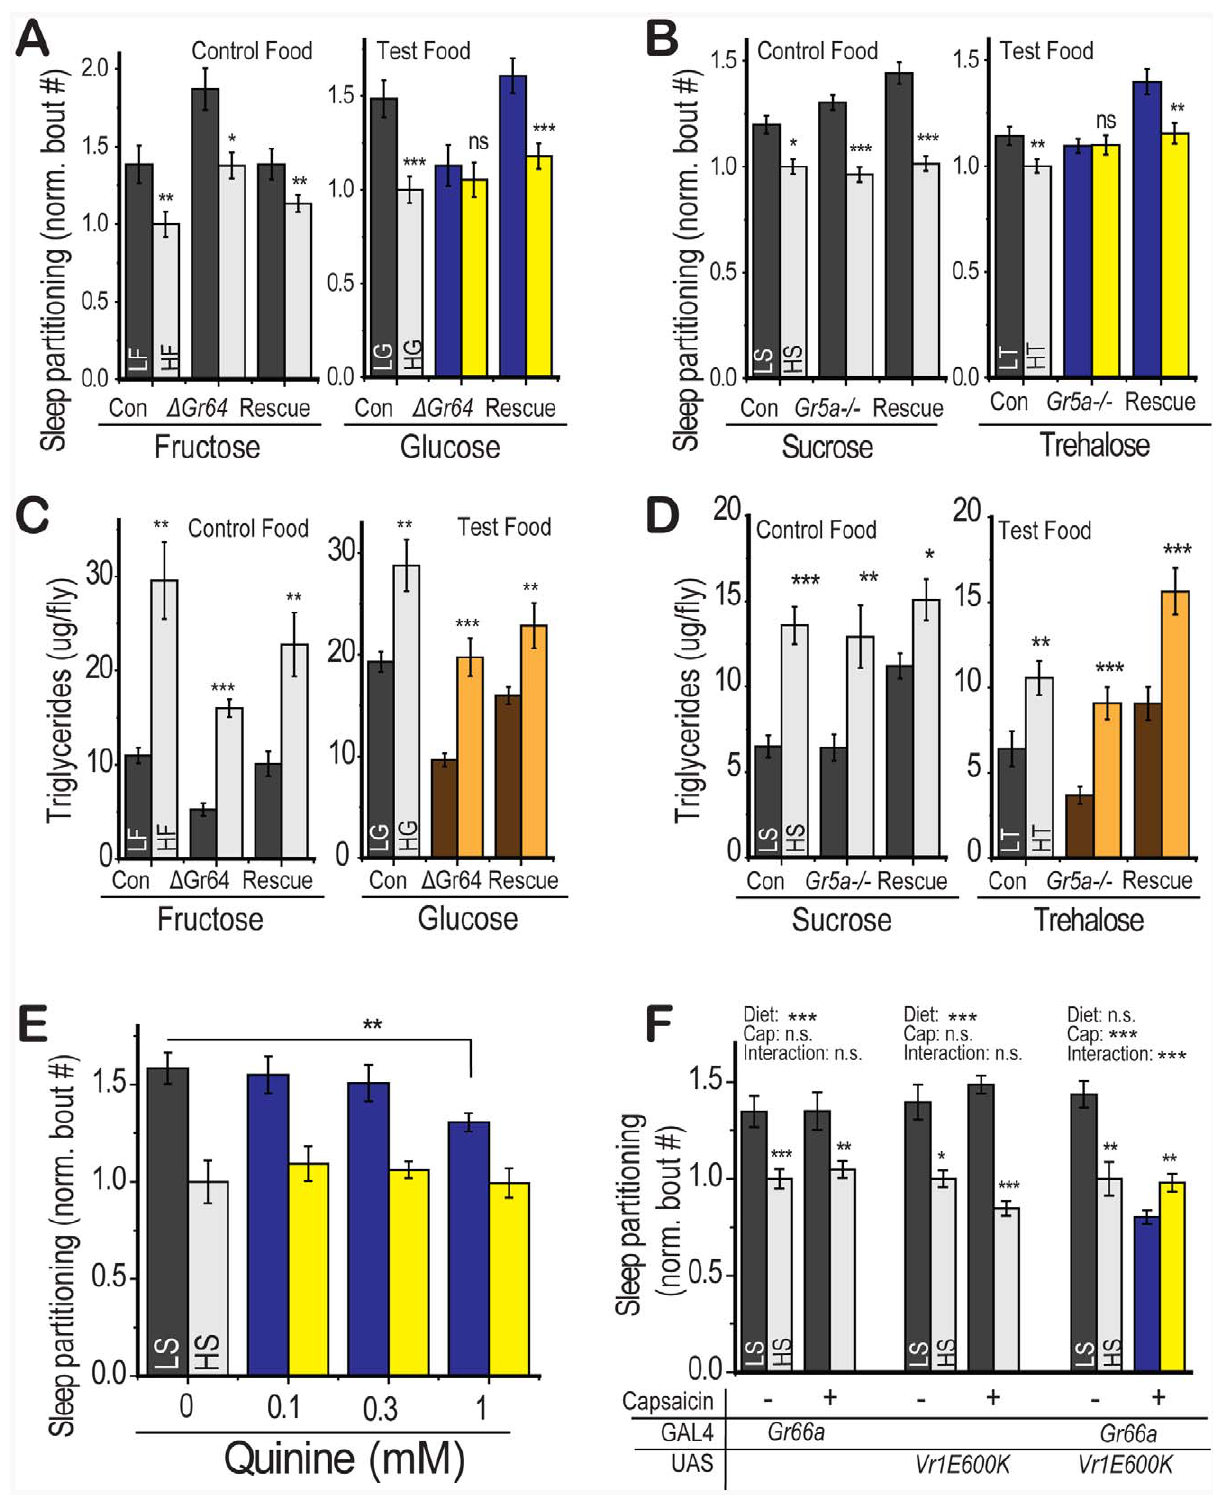
Figure 5. Gustatory inputs mediate sleep partitioning in response to dietary sugar. For each indicated sugar, flies were tested on a medium with 2.5% or 30% of that sugar on a 2.5% yeast base. (A) Flies with a deletion in the Gr64a-f sweet-sensing cluster retained sensitivity to fructose (control food) but were insensitive to a glucose-containing food (test food). This effect was rescued by expression of a UAS- Gr64abcd_GFP_f construct with a Gr5a -GAL4 promoter in the Gr64 deletion background. (B) Flies with a deletion in the Gr5a trehalose receptor retained sensitivity to sucrose (control food) but were insensitive to a trehalose-containing food (test food). This effect was rescued by expression of a UAS- Gr5a with a Gr5a -GAL4 promoter. Deletion of (C) the Gr64 cluster or (D) Gr5a did not compromise the rapid shift in energy storage following dietary switch on either the control or test food. (E) Quinine supplementation of the food at the indicated concentrations (significance value from one-way ANOVA